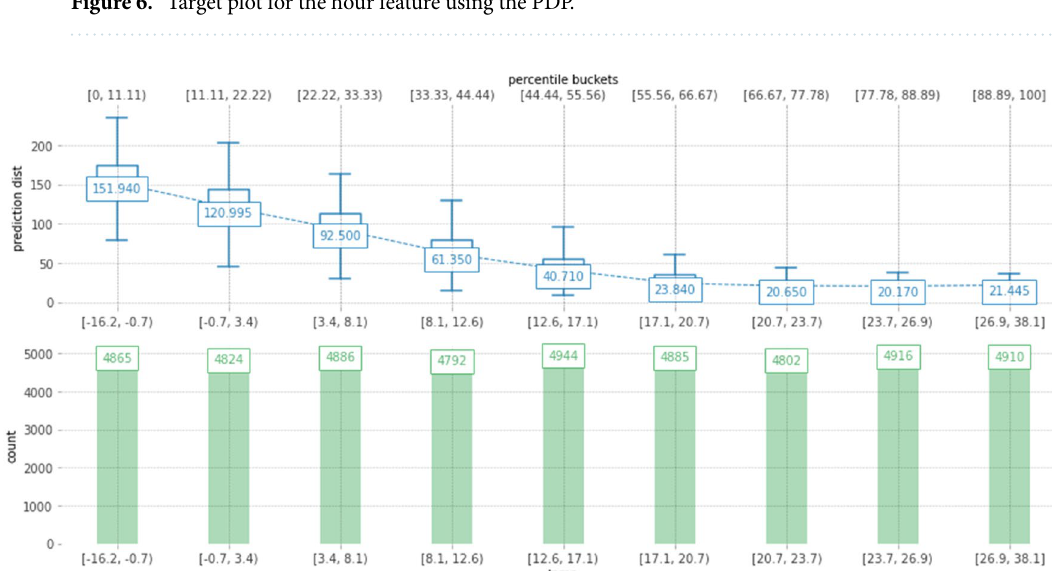
Figure 7. Actual heat usage prediction plot for the temperature feature using the